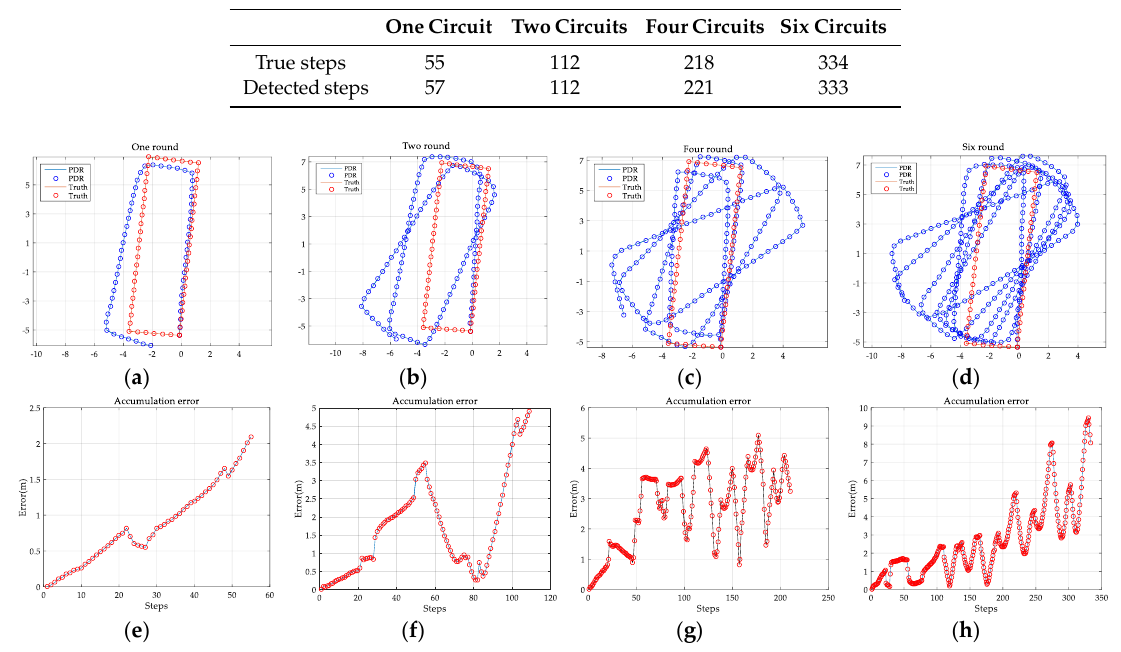
Figure 7. The trajectory and accumulative error of PDR: ( a – d ) are the estimated trajectories of walking around the rectangular route from circuit one to circuit six; ( e – h ) are the corresponding accumulative errors of ( a – d ).